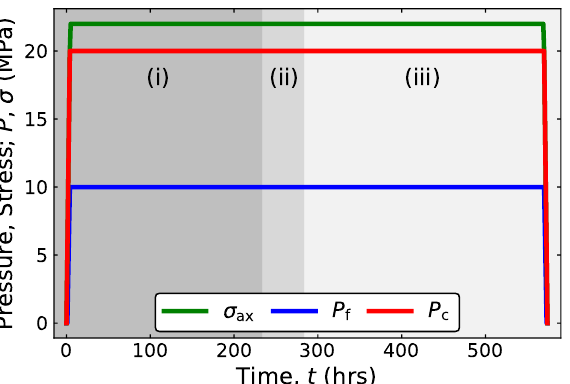
Figure 5. Confining pressure P c , pore pressure P f , and axial stress σ ax versus time t . Roman num- bering combined with the grayscale background indicates the respective phases of fluid exposure: Phase (i), Phase (ii), and Phase